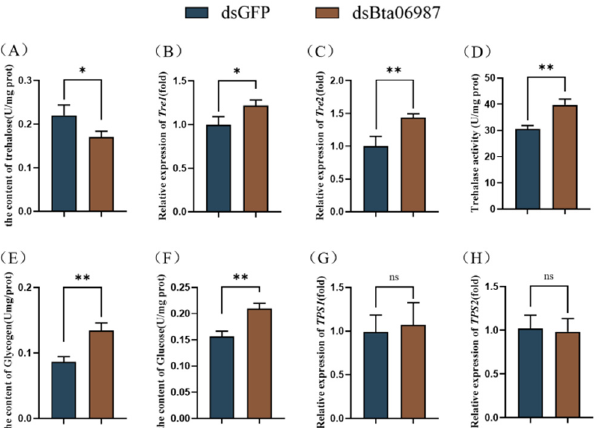
Figure 4. Carbohydrate content and the relative expression of related genes. ( A ) The content of trehalose and ( B ) the relative expression of Tre1 . ( C ) Tre2 , ( D ) the activity of trehalase, ( E ) the content of glycogen, ( F ) the content of glucose. ( G ) The relative expression of TPS1 and ( H ) TPS2 . The data are shown as means ± SE of three independent experiments. Significant differences based on Student’s t -test are denoted as * p < 0.05 and ** p < 0.01; no significant differences based on Student’s t -test are denoted as ns.